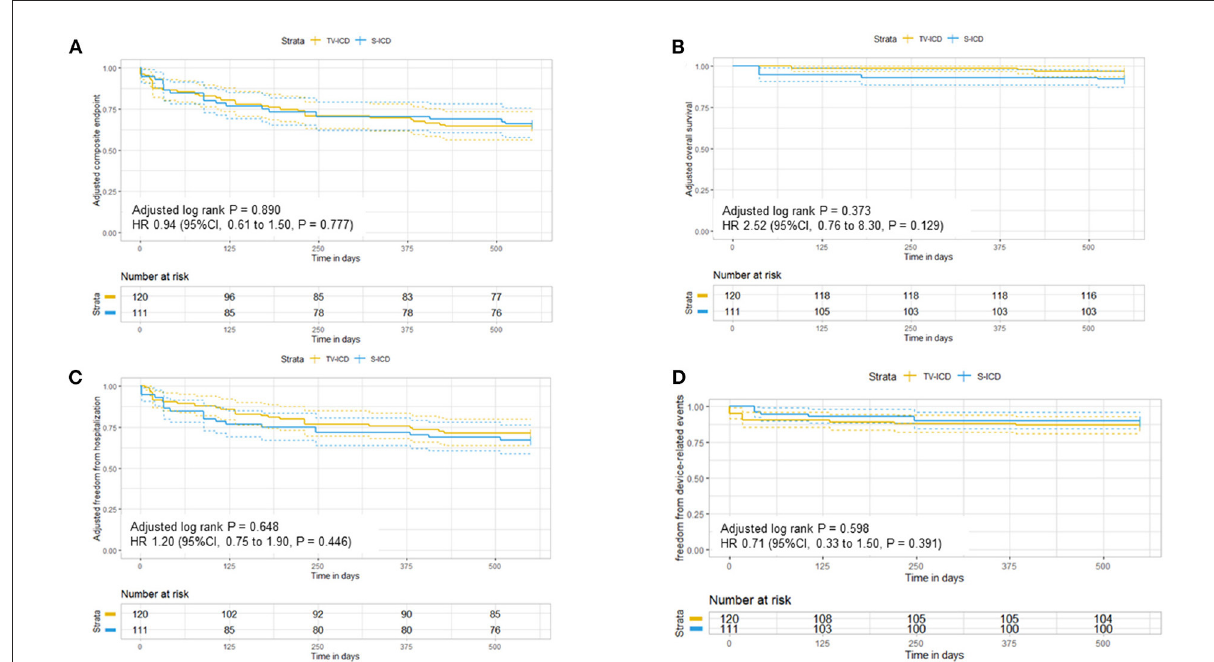
FIGURE2 Adjusted Kaplan-Meier curves in patients with subcutaneous and transvenous ICD following inverse probability weighting for (A) the composite endpoint, (B) overall survival, (C) freedom of hospitalization, and (D) freedom of the device-related events at 1.5